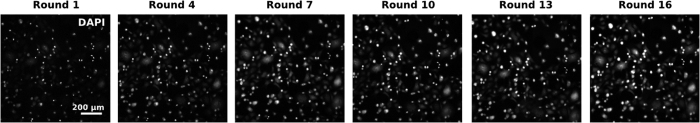
Durability of REMI media.In an extended test of REMI sample durability, mouse fibroblast cells were plated onto a dish with a thin coat of carbon to enhance adhesion, embedded in LRW, and imaged at low resolution with DAPI-containing media (SlowFade Gold). Between each image, the sample underwent three washes of high-pH solution, at 20 minutes per wash, simulating three elution cycles. This was repeated to destruction for each sample; when catastrophic “lifting” of the entire cell layer would occur. Average lifetime of 14 + /−1.6 rounds, n = 3.